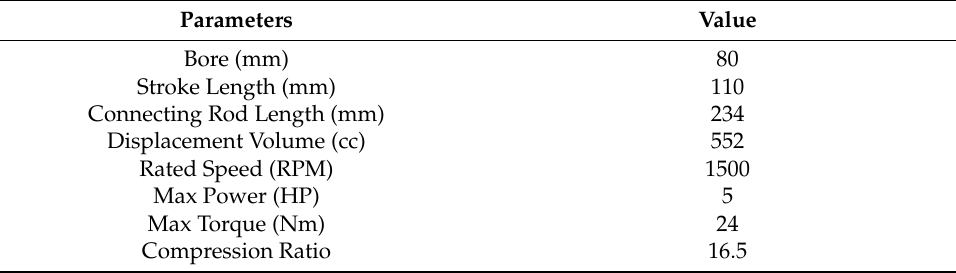
Figure 13. Digital image of diesel engine (Make: Kirloskar). Table 3. Engine specifications (Make: Kirloskar).